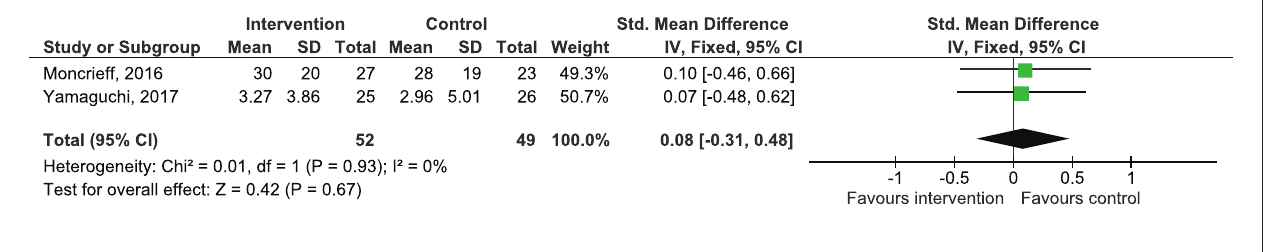
FIGURE 5 | Forest plot for adverse events defined as harms or side effects.